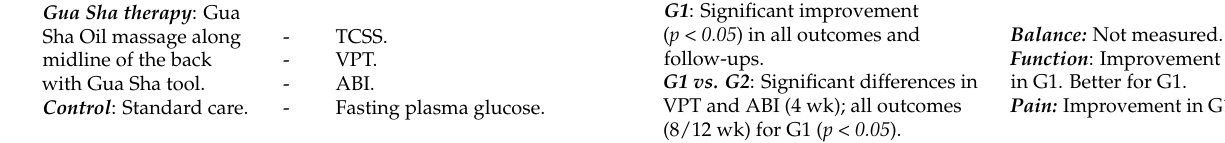
Manual Therapy : Carpal bone mobilisation, transverse carpal ligament release, palmar fascia release of the hand, soft tissue manipulation in the distal arm and proximal forearm areas and median nerve mobilisation.